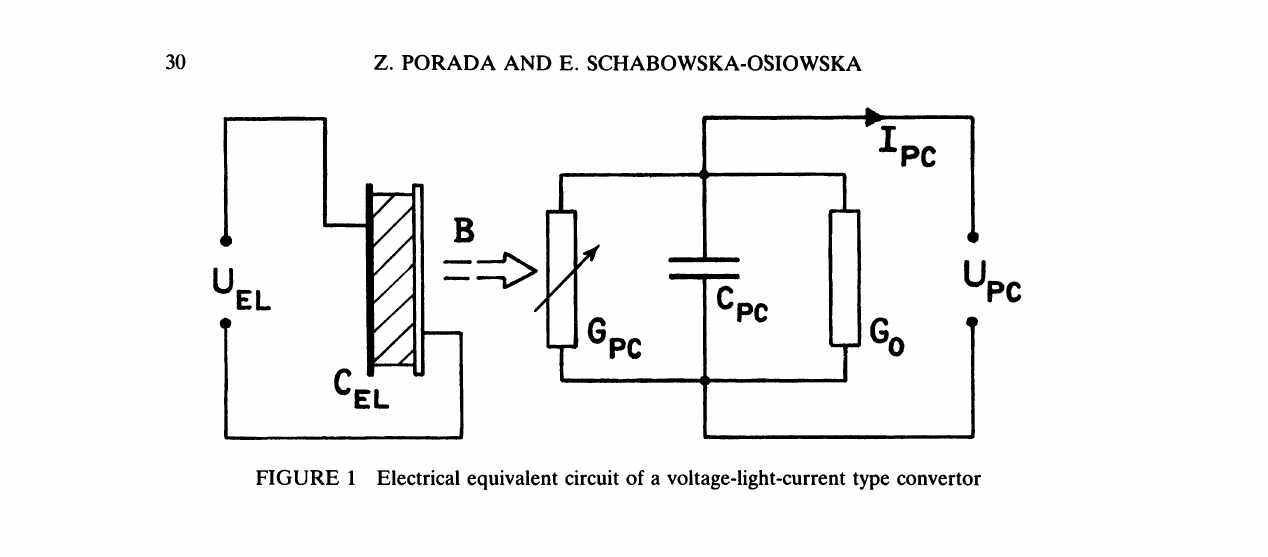
FIGURE Electrical equivalent circuit of a voltage-light-current type